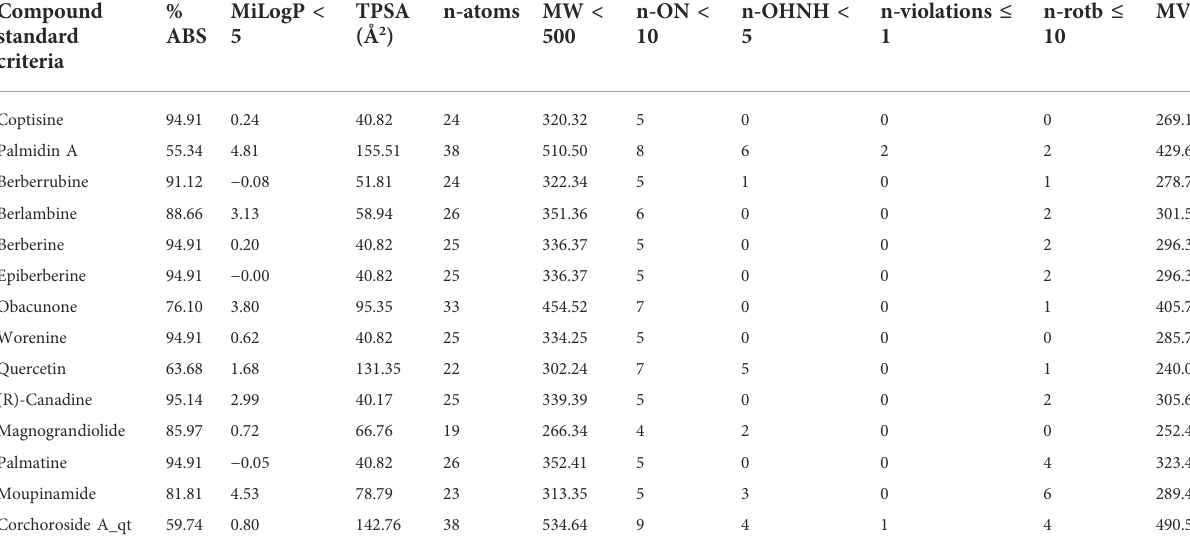
TABLE 2 Physicochemical properties of key phytochemicals of CR.